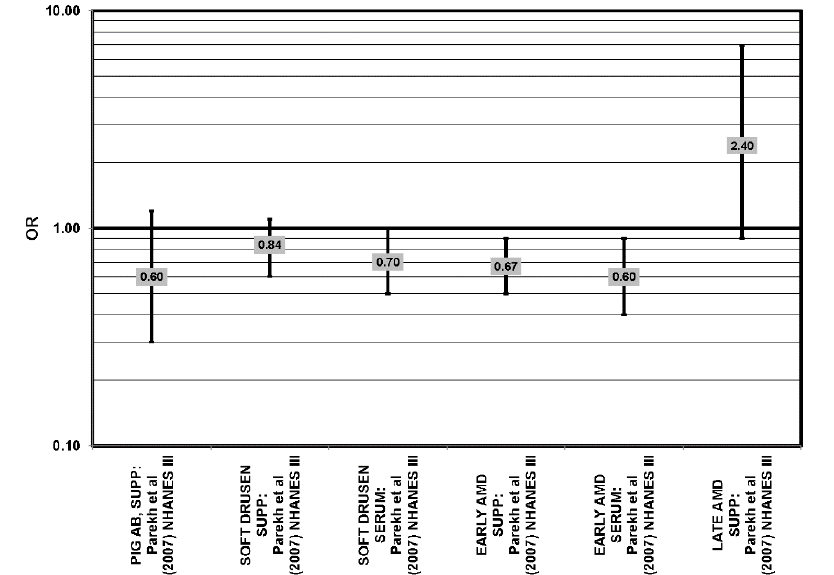
Figure 42. Odds ratio for early AMD, indicators of early AMD (SOFT DRUSEN, PIG AB) or advanced AMD upon vitamin D supplementation in in those at least 40 years of age who do not consume milk daily: retrospective